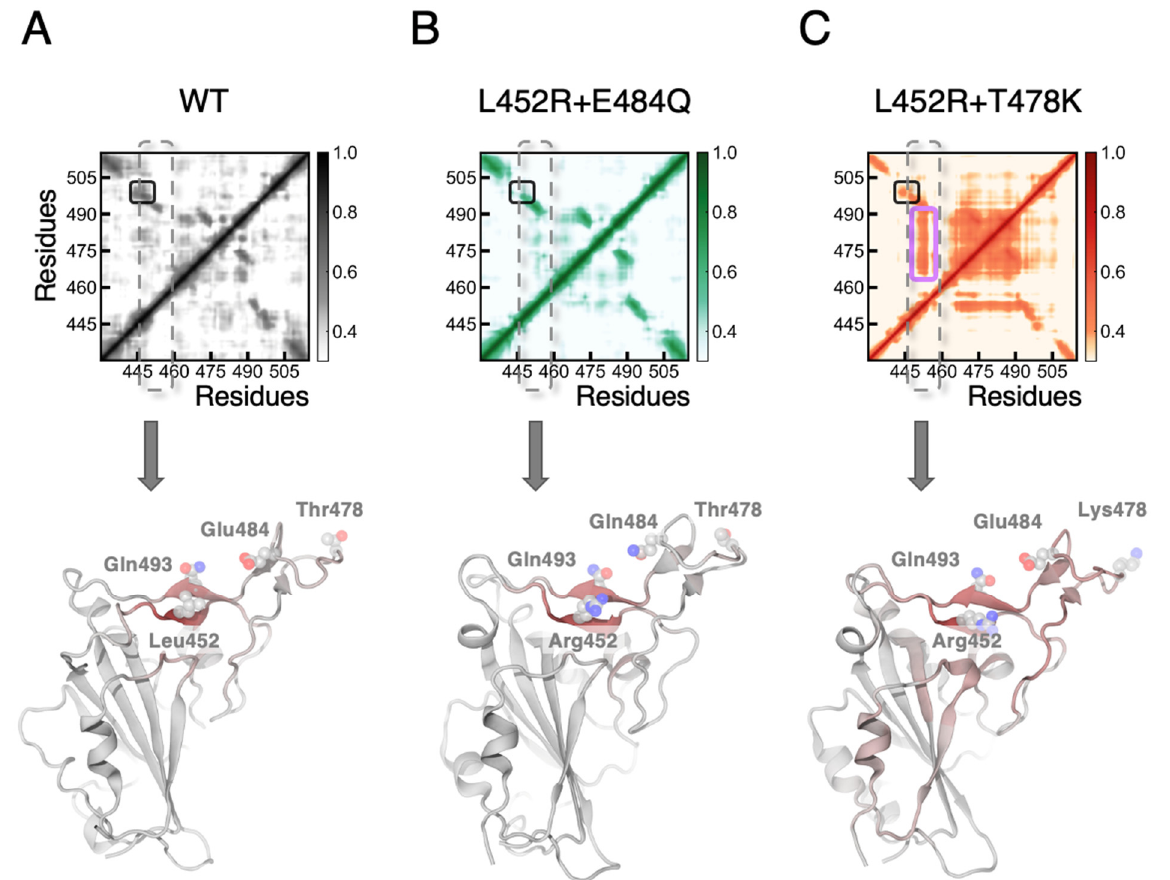
Figure 3. Generalized correlation analysis for wild type ( A ), mutation L452R + E484Q ( B ), and mutation L452R + T478K ( C ). Above are the generalized correlation matrices. Black and magenta boxes indicate the correlations between residue 452 and residue 493 or residues 469–493, respectively. Grey dashed boxes indicate the correlation involved residues 450 to 454. Below are mapping of averaged correlation with residues 450 to 454 onto every other residue. Red colors represent the degrees of correlation while white colors indicate no correlation. Key residues are shown as spheres.